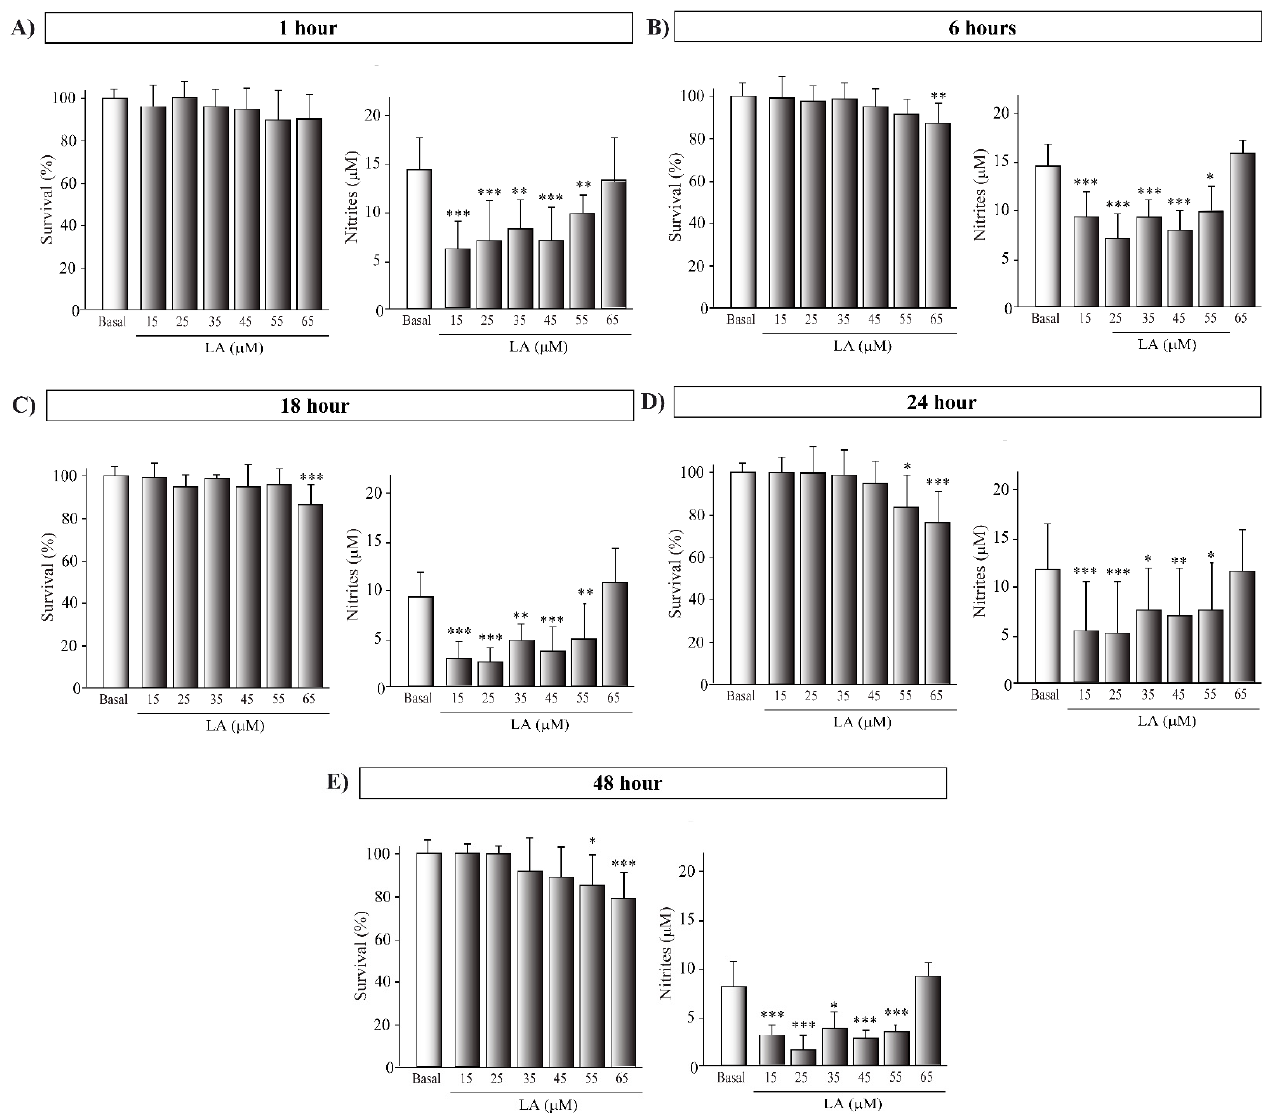
Figure A1. Neuroprotective and anti-inflammatory effect of LA on a hemiparkinsonian animal model. Representative images of coronal sections of the mouse SNpc showing the presence of dopaminergic neurons (TH, blue); astroglial cells labeled with glial fibrillary acidic protein (GFAP, green) and Tomato lectin (red) as a marker of activated microglial cells, both in the contralateral (not injected) and ipsilateral (injected) hemisphere. Scale bar, 200 μ m.